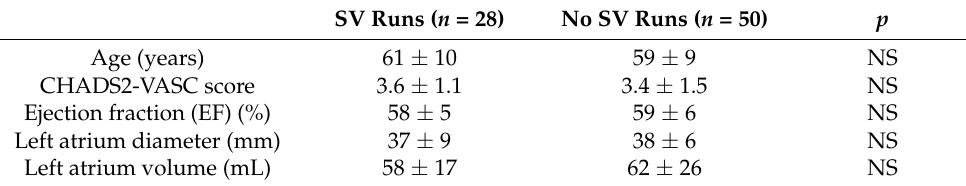
Table 3. Patients with SV runs vs. without SV runs—clinical and echo parameters.